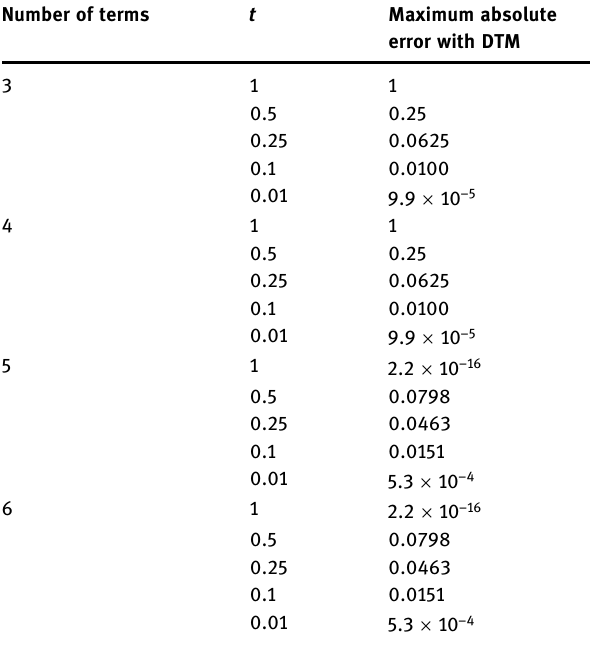
Table 4: The error with respect to “ t ” value and the number of terms in the approximate solution by the D ( TQ ) M method